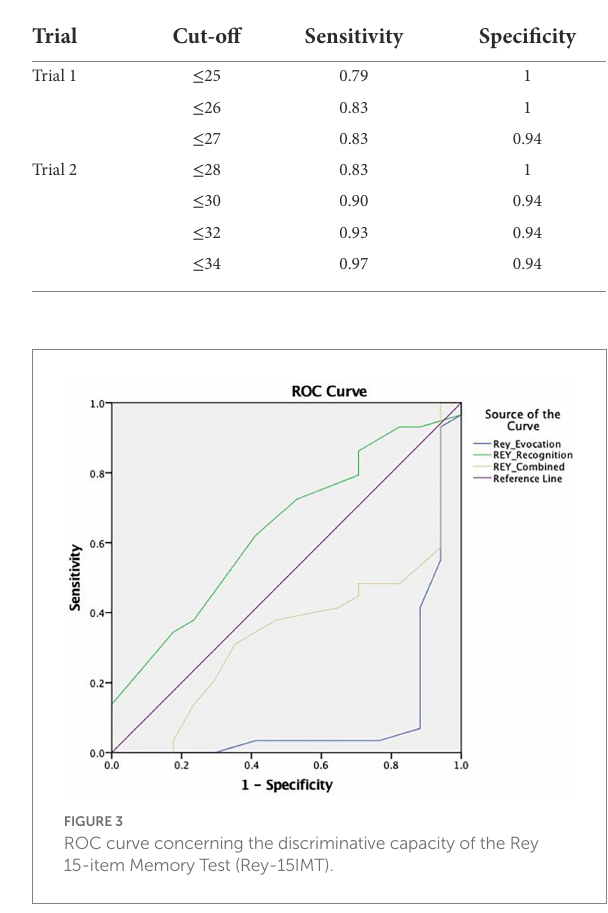
TABLE 4 TOMM’s cut-off points sensitivity and specificity for older adults with dementia.